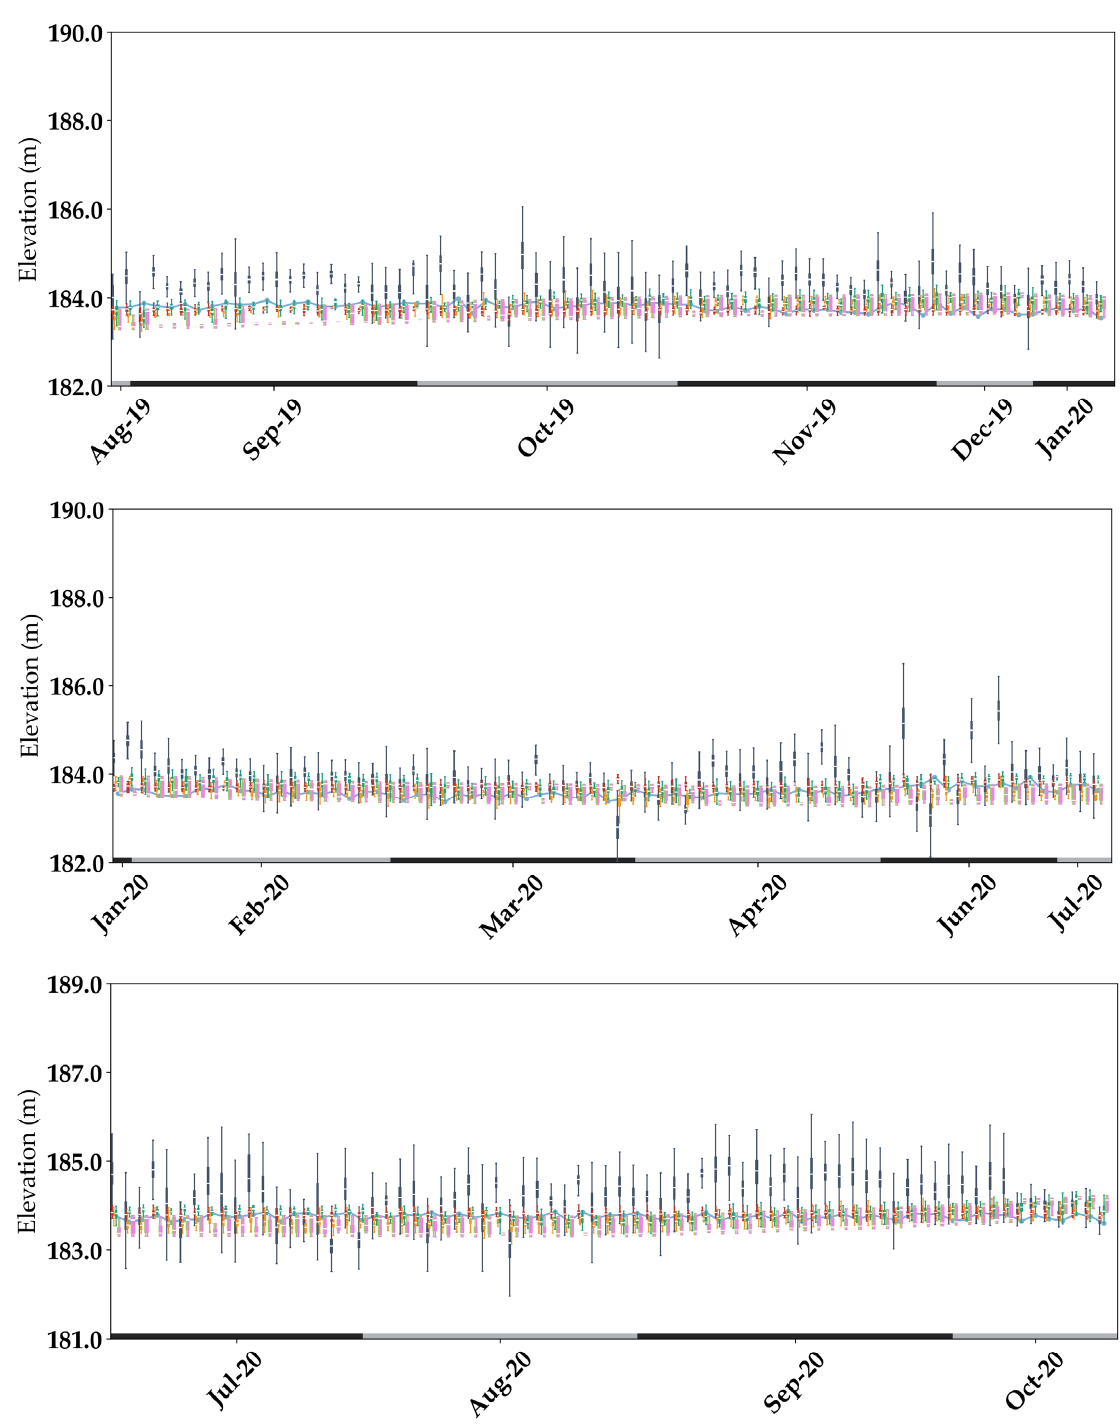
Figure A10. Boxplot by track of the original estimated elevations by GEDI over Lake Superior and the five tested models presented in Section 3.1.3. The green line represents in situ elevations. RF CV repre- sents the 5-fold cross-validation results over Lake Superior. RF Erie → Superior , RF Huron → Superior , RF Ontario → Superior , and RF Michigan → Superior represent the results of the models trained over Lakes Erie, Huron, Ontario, and Michigan, respectively, and applied over Lake